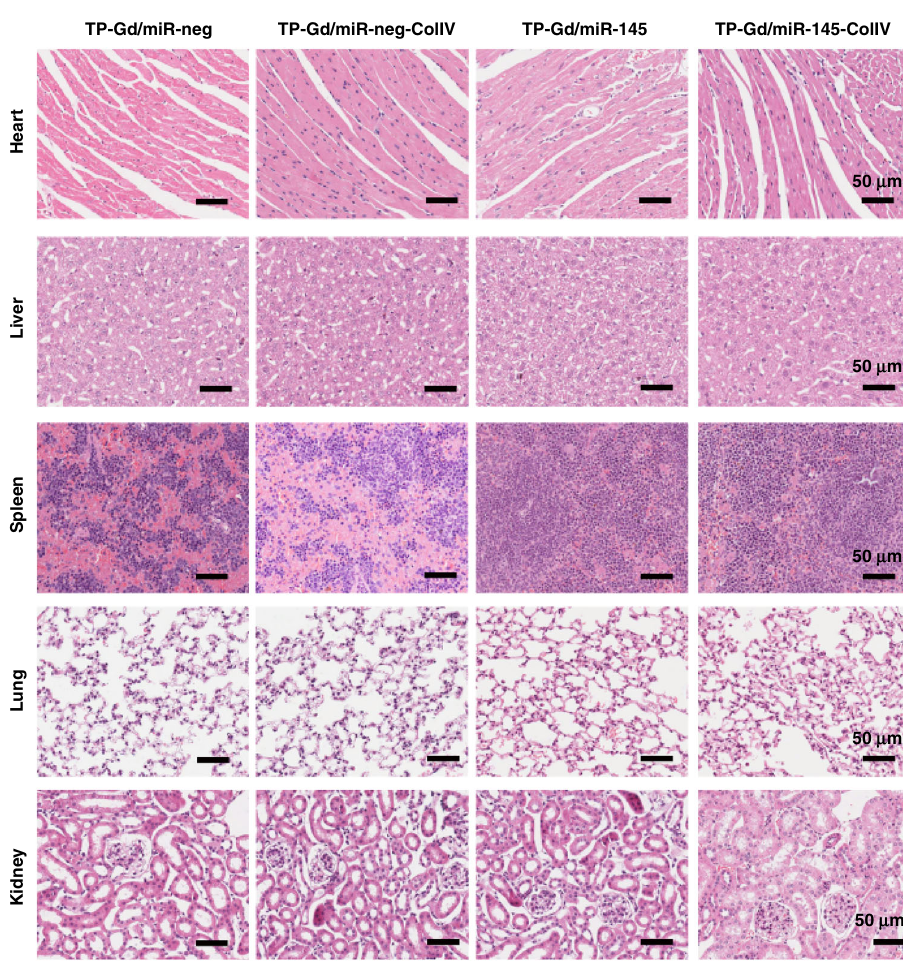
Fig. 8 Representative photographs of H&E staining of paraf fi n-embedded sections of organs in TP-containing polycation/miRNA